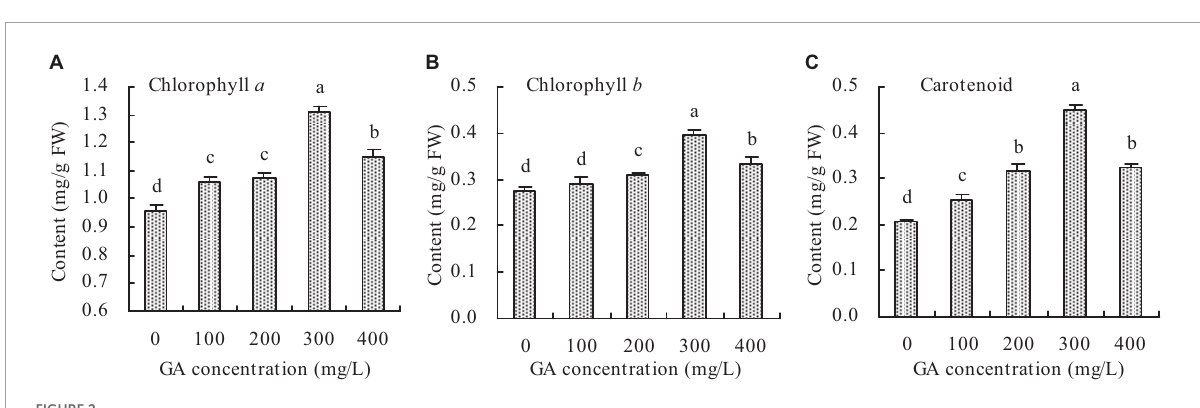
FIGURE2 Photosynthetic pigment content in C. betacea . (A) Chlorophyll a content. (B) Chlorophyll b content. (C) Carotenoid content. Different lowercase letters indicate significant differences among the treatments (Duncan’s Multiple Range Test, P < 0.05).